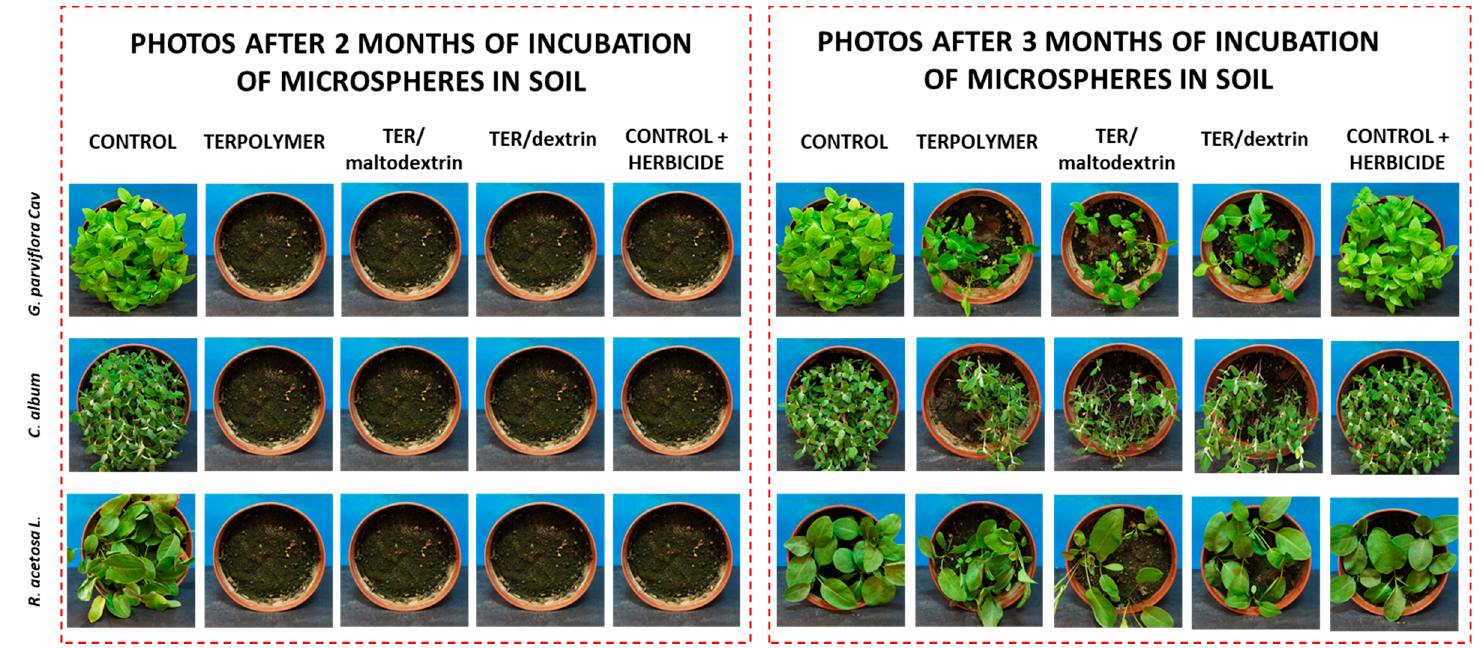
Figure 10. Herbicidal activity assessment of released metazachlor loaded into microspheres in double recommended dose. Seeds of each plant were sown after two and three months of incubation of microspheres in soil.